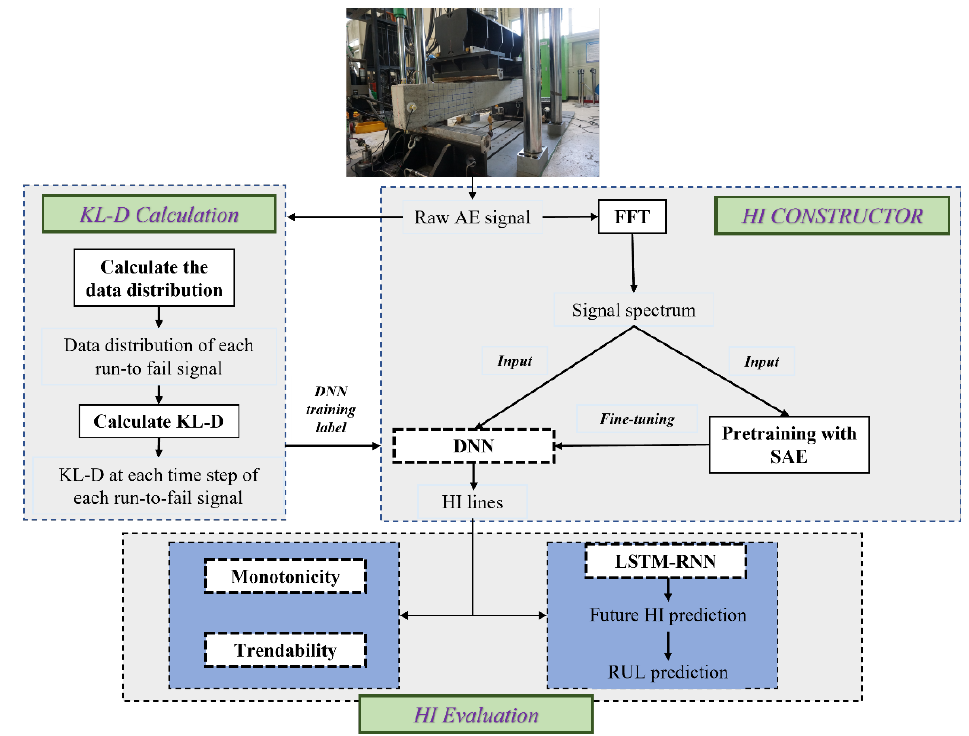
Figure 1. Flowchart of the HI construction framework and evaluation process.